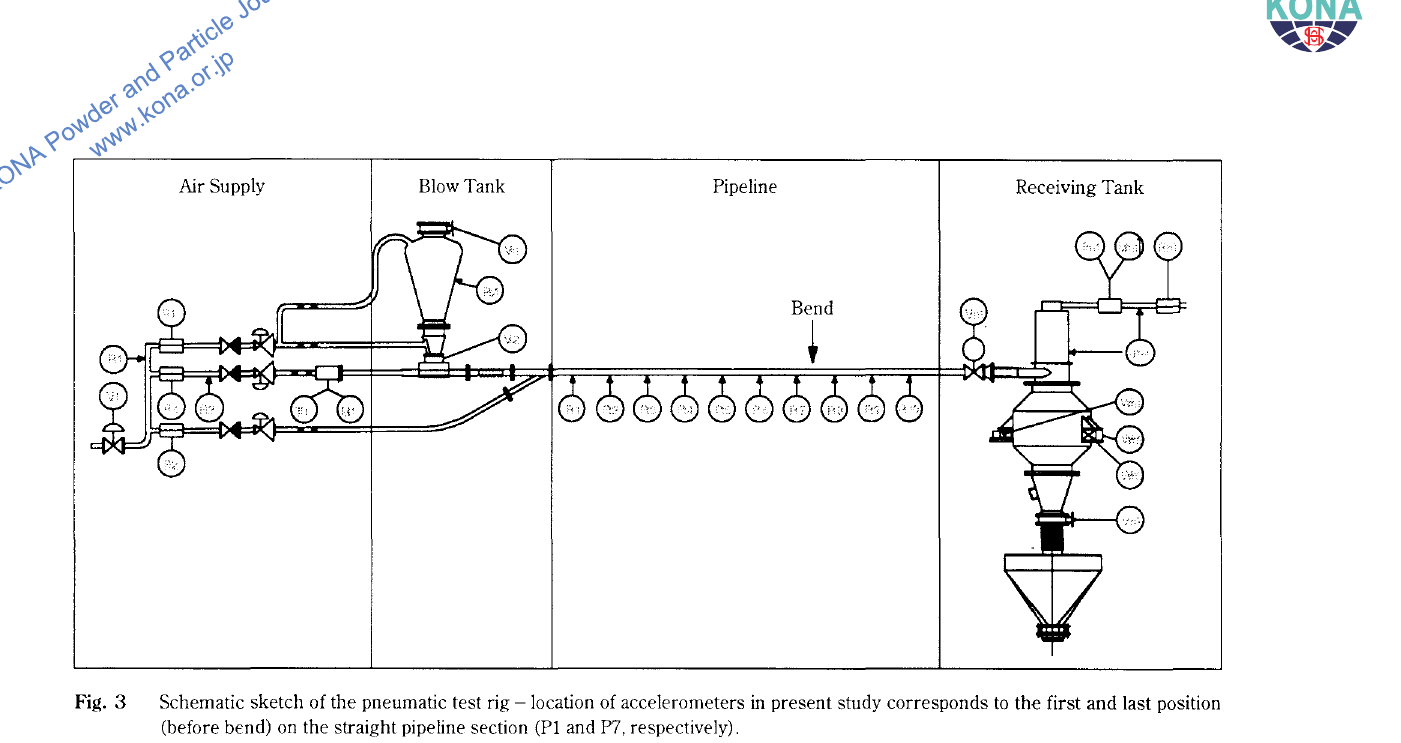
Schematic sketch of the pneumatic test rig -location of accelerometers in present study corresponds to the first and last position (before bend) on the straight pipeline section (PI and P7, respectively).